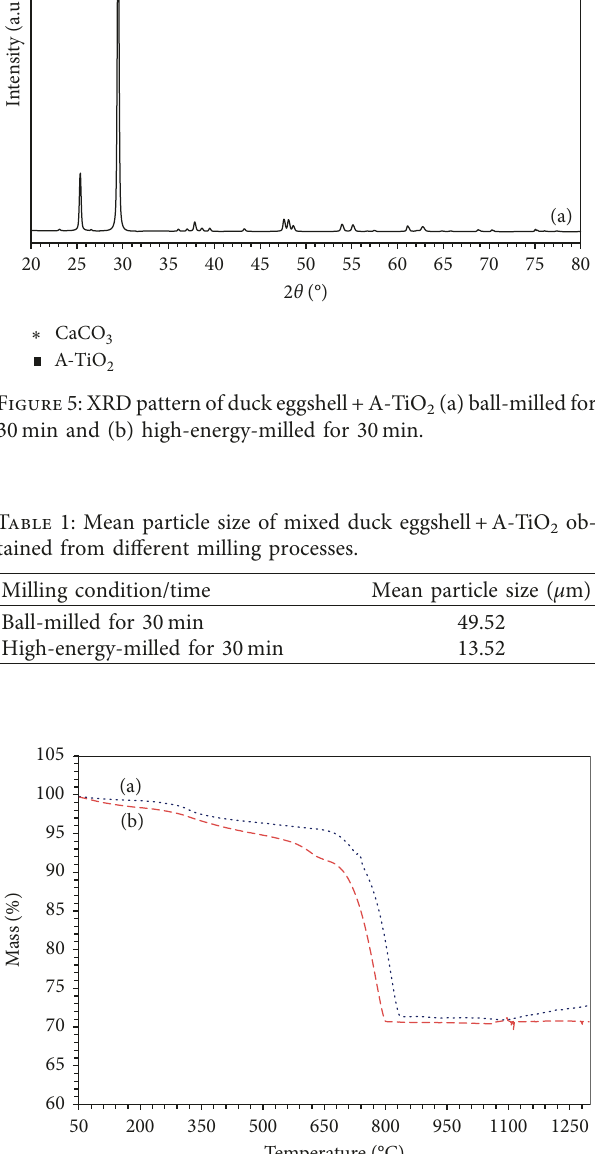
2 (a) ball-milled for